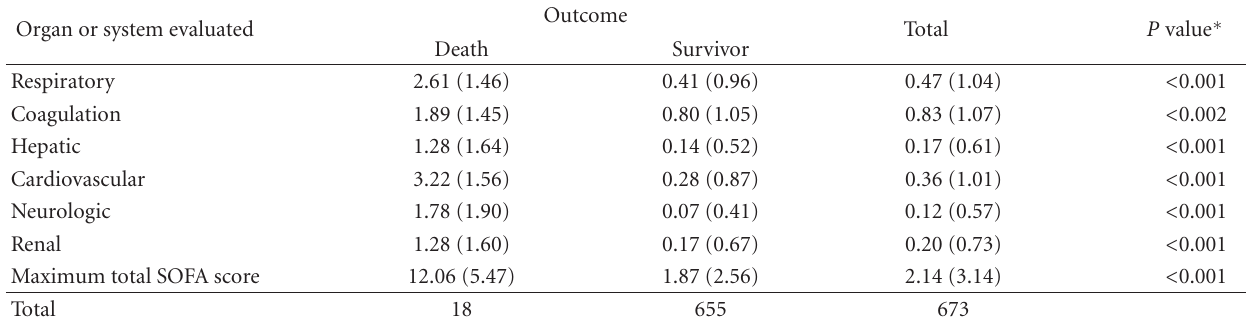
Table 1: Mean and standard deviation of maximum Sequential Organ Failure Assessment (SOFA) score for each organ or system evaluated and the total score, according to the outcome of cases of severe maternal morbidity admitted to an obstetric intensive care Unit.